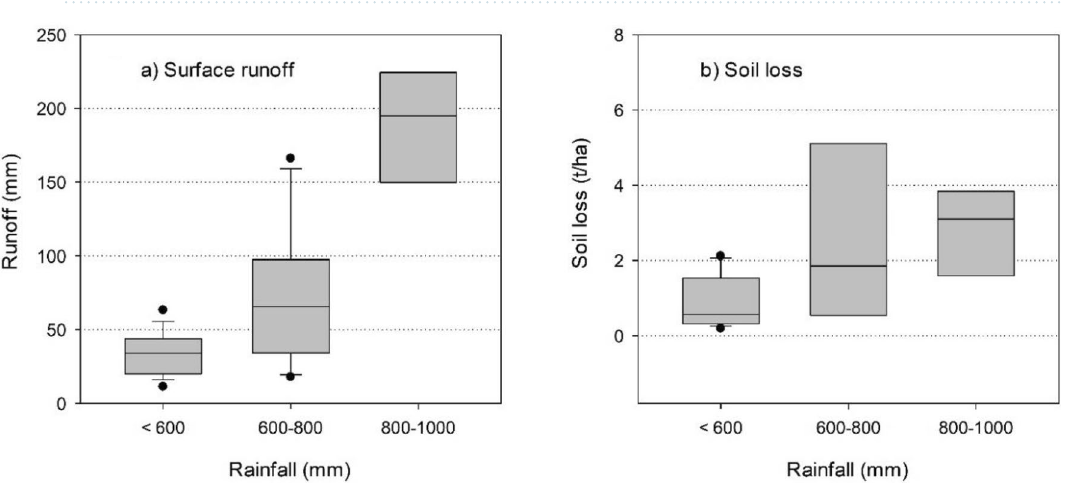
Figure 8. ( a ) Surface runoff and ( b ) soil loss from low, medium and high rainfall zones of the semi-arid